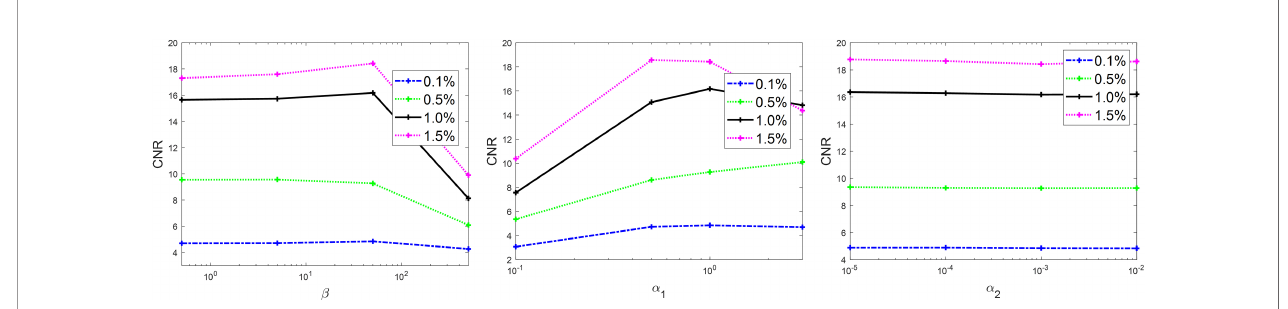
FIGURE 3 | Sensitivity analysis on b (left), a 1 (middle), and a